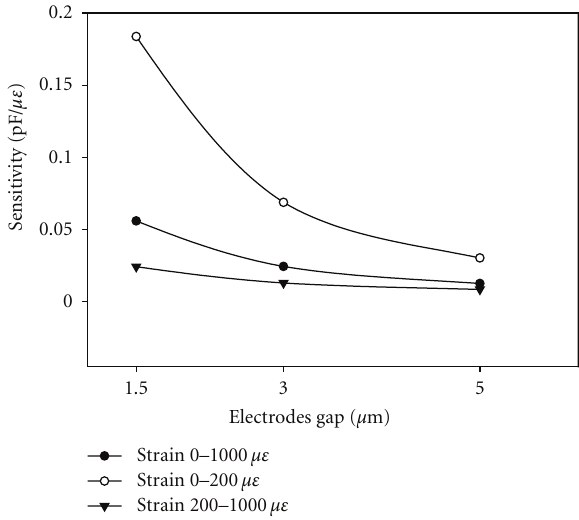
Figure 6: Sensitivity comparison of di ff erent electrodes gap at di ff erent strain